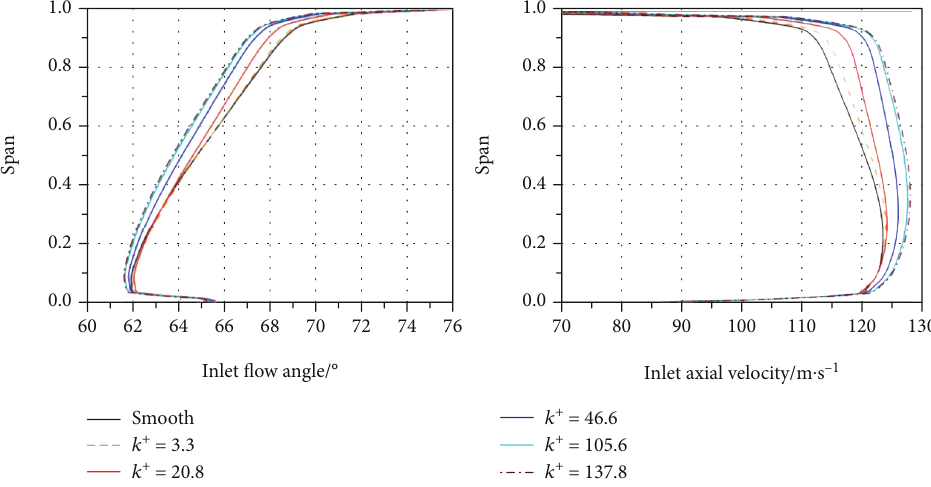
Figure 15: The spanwise distributions of the inlet parameters for the rotor at di ff erent k +